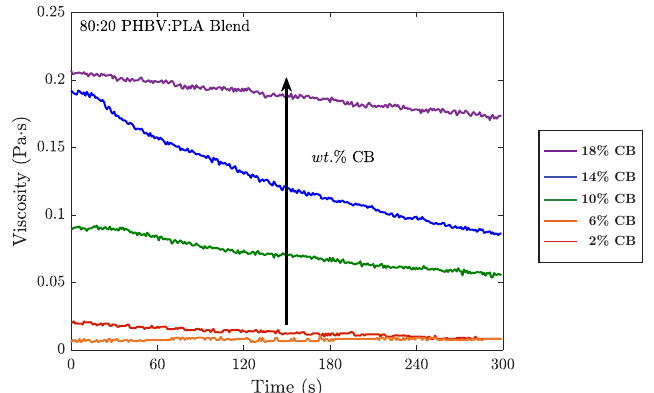
Figure 5. Melt rheology of the 80:20 PHBV:PLA blends during melt blending. Increasing wt.% of CB causes an increase in in the viscosity of blends during